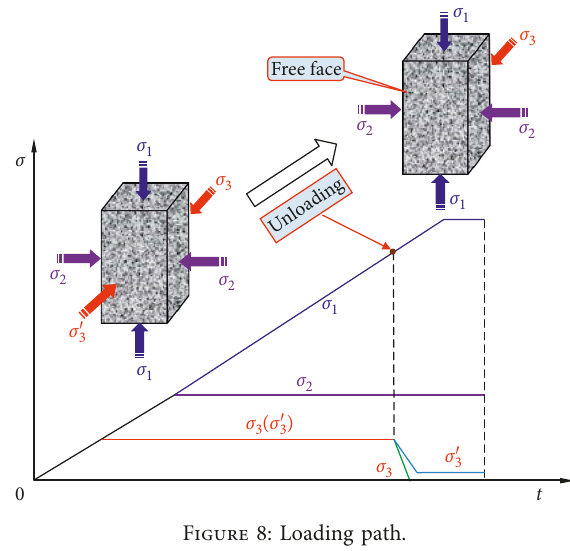
Figure 8: Loading